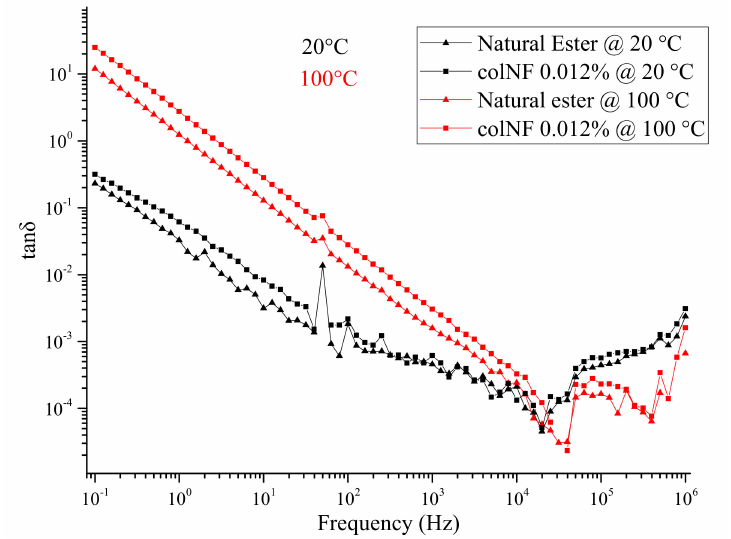
Figure 5. Dielectric losses (tan δ ) for natural ester oil and colNF 0.012% at 20 ◦ C and 100 ◦